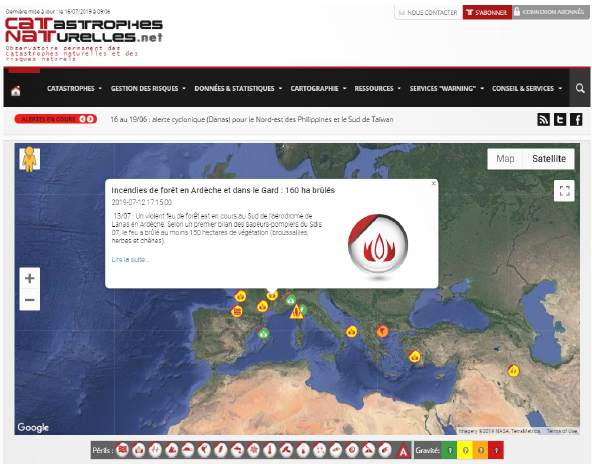
Figure 4. Figure catnat site web